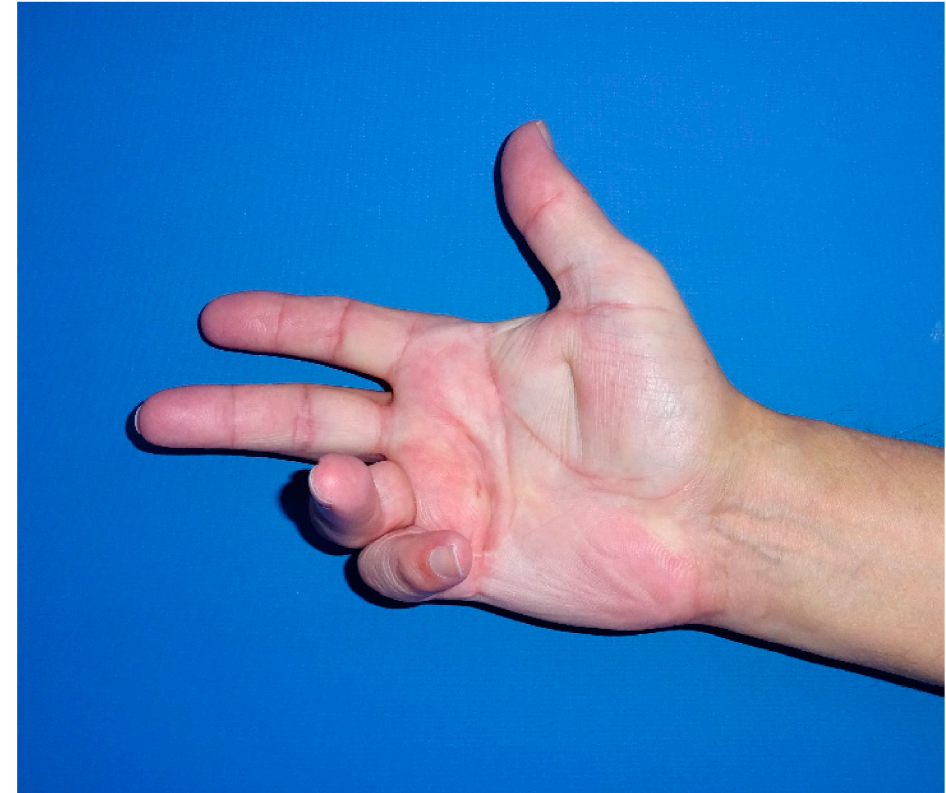
Figure 5. Patient with stage IV DD of the little